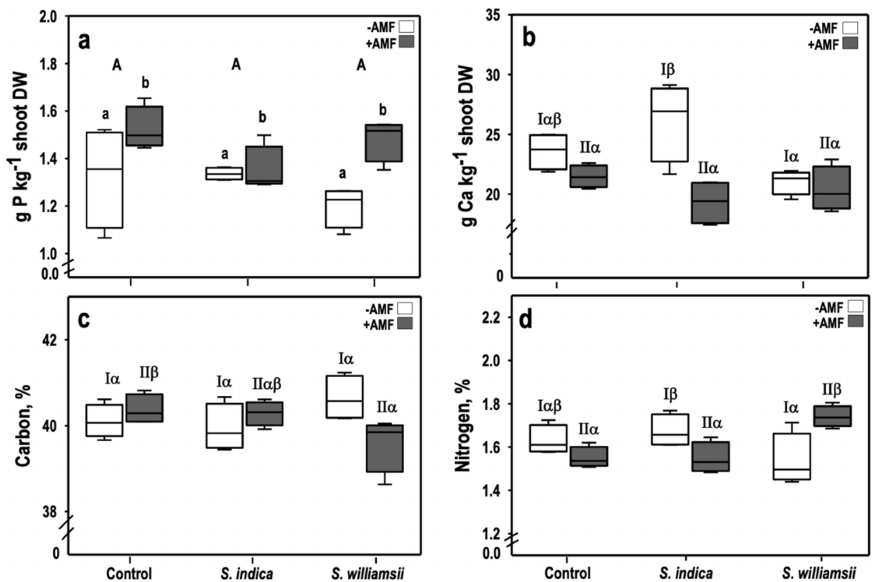
Figure4. Macronutrientconcentrationintomatoshootsnineweeksaftertransplanting: phosphorus( a )andcalcium ( b ) (in g · kg − 1 shoot dry weight) and carbon ( c ) and nitrogen ( d ) (in %). Upper-case letters indicate differences in